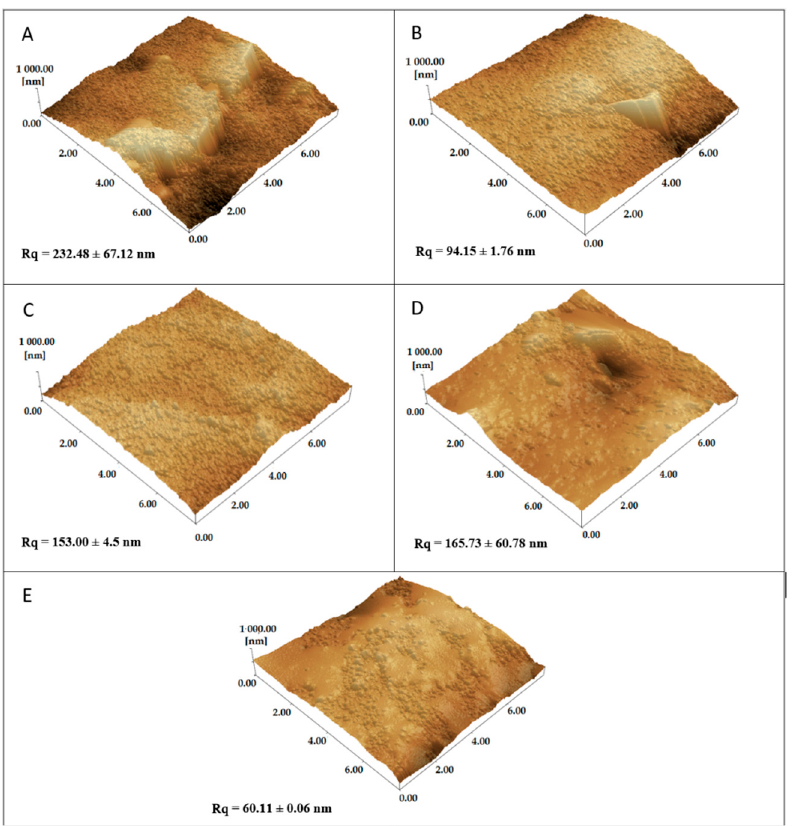
Figure 6. Atomic force microscopy (AFM) images of graphite electrode (C110) ( A ); 4-DMAA added to C110 ( B ); LC1 added to C110 followed by 4-DMAP ( C ); LC1 + 4-DMAP with serum IgG-positive ( D ); LC1 + 4-DMAP with serum IgG-negative ( E ). Rq is equivalent to roughness values.